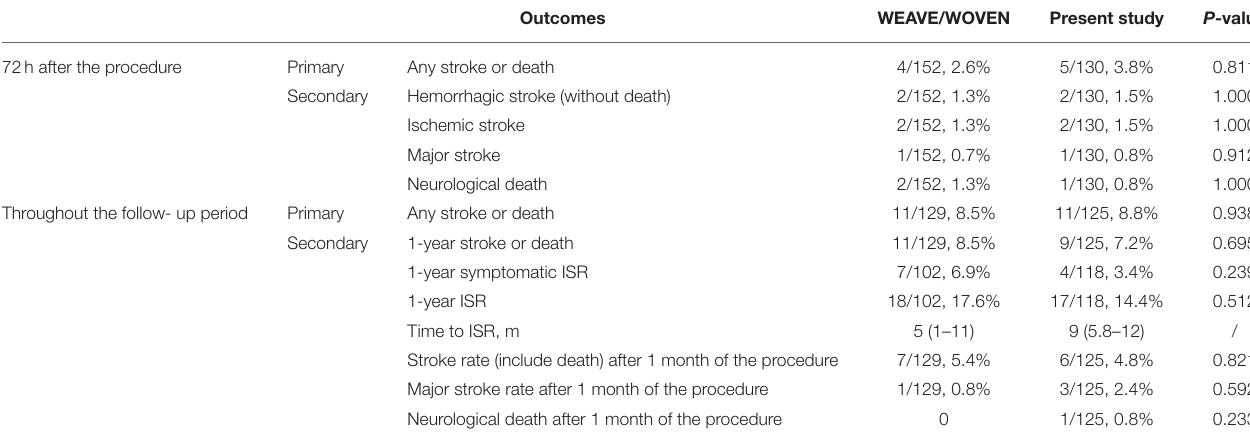
TABLE 4 | Comparison of the outcomes between the WEAVE/WOVEN trial and the present study. Outcomes WEAVE/WOVEN Present